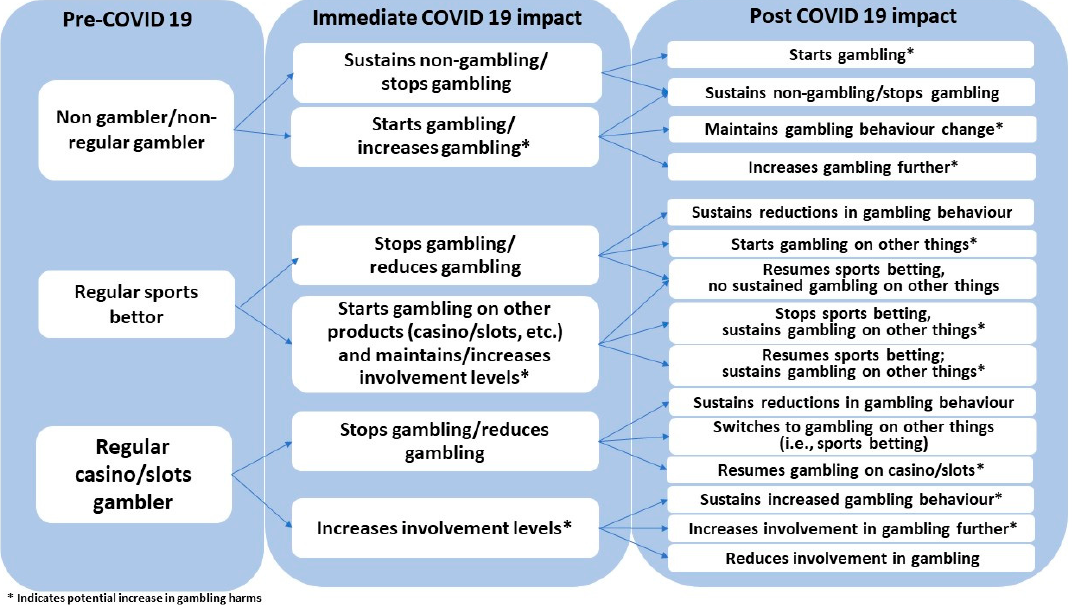
Figure 2. Potential pathways to COVID-19-related changes in gambling behaviours.